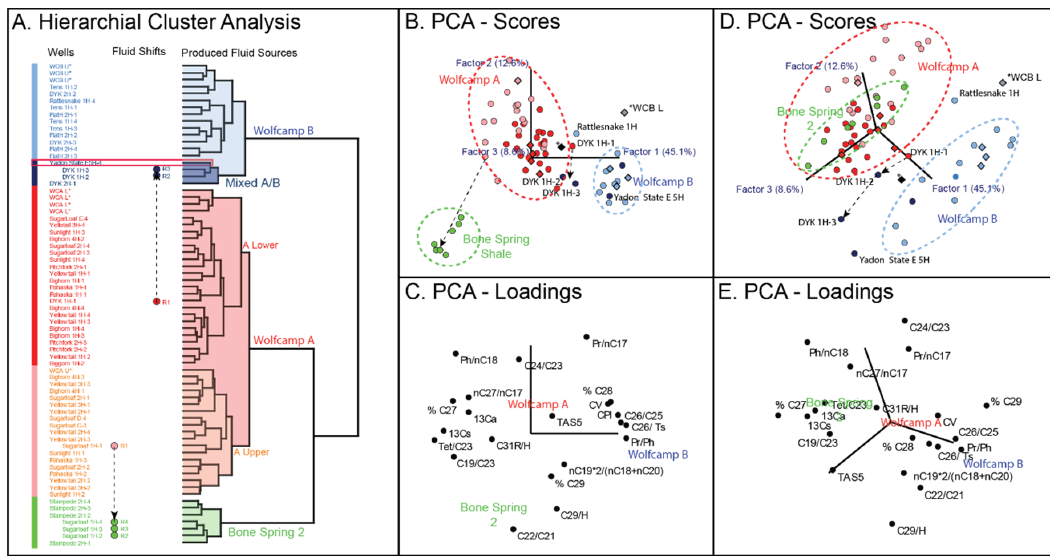
Figure 8. Statistical diagrams for the core extracts and produced oils (All Sample Rounds) analyzed as part of this study. ( A ) Hierarchical Cluster Analysis (HCA) Dendrogram showing how the oil and extract samples group into tribes geochemically. The source of the produced fluids is defined based upon core-oil correlations, and movement of produced oils between sampling rounds is shown. ( B ) Principal Component Analysis (PCA) scores plots showing the distribution of all of the samples. The artificially mixed Wolfcamp A/B oil is highlighted as are fluids showing potential mixing or movement between sampling rounds. ( C ) Principal Component Analysis (PCA) loadings plot showing the biomarker ratios which define the scores plots. ( D ) Rotated Principal Component Analysis (PCA) plot. ( E ) Rotated Principal Component Analysis (PCA) loadings plot from 21 biomarker and isotope ratios.